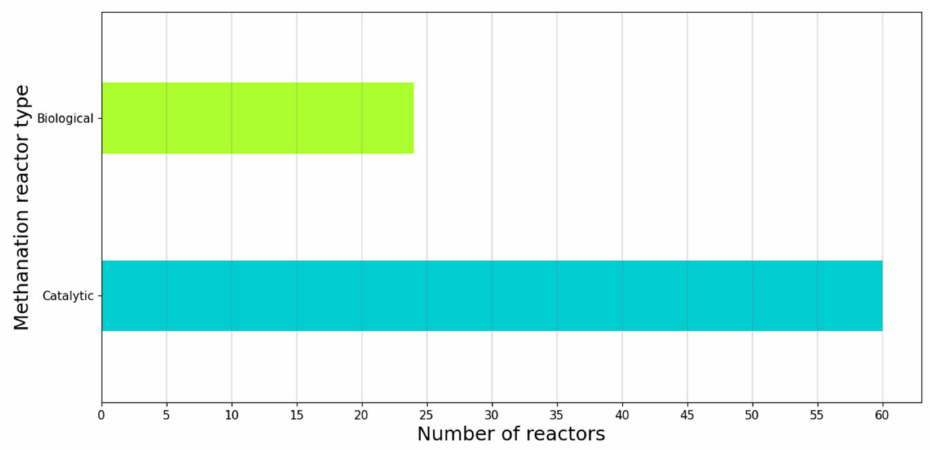
Figure 6. Grouping power-to-gas projects per methanation